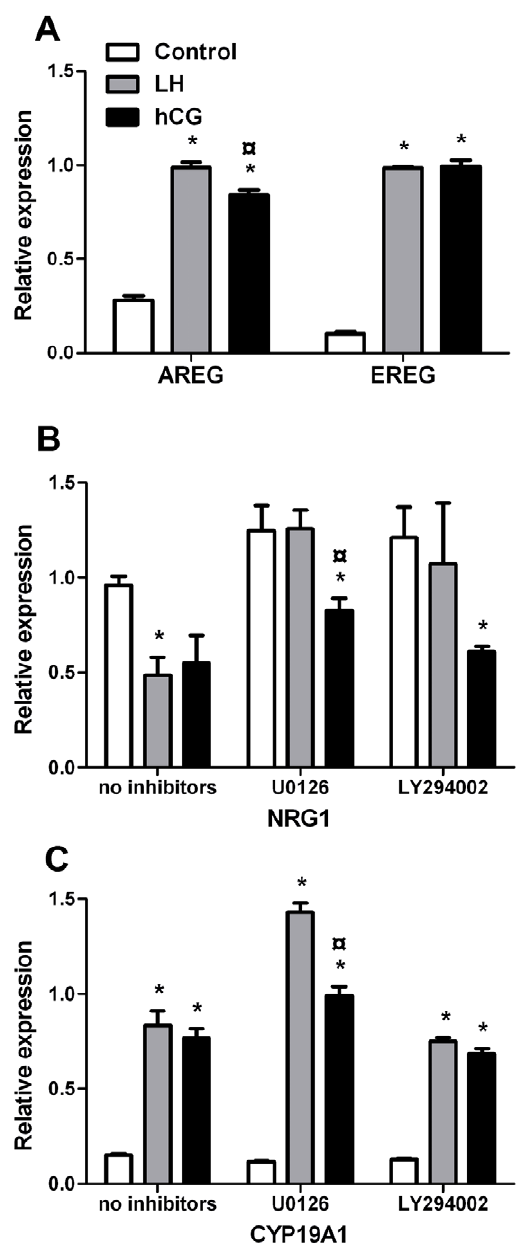
Figure 8. Evaluation of the gene expression induced in hGLC by hLH or hCG stimulation after 12 hours, performed by real- time PCR. Specific ERK1/2- or AKT-pathways inhibitor (U0126 and LY294002 respectively) were also used where indicated. a. Increase in the gene expression of the EGF-like factors amphiregulin ( AREG ) and epiregulin ( EREG ) induced by LH or hCG. b. Effects of the hLH or hCG stimulation and of the ERK1/2- or AKT pathway early inhibition on neuregulin 1 ( NRG1 ) gene expression. c. Effects of the hLH or hCG stimulation and of the ERK1/2- or AKT pathway early inhibition on NRG1 gene expression. In each treatments, RPS7 gene expression was used as normalizer (mean 6 SEM; n=4; *=significant vs control; u =significant vs hLH-stimulated; t-test ; p ,